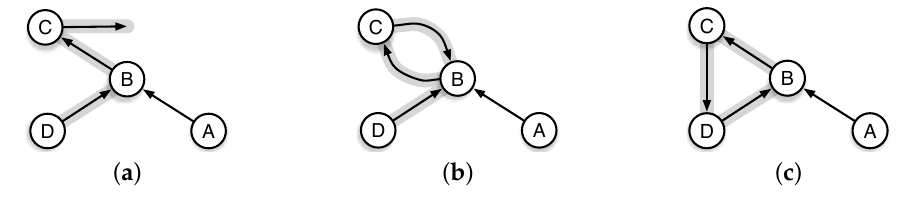
Figure 1. Illustration of the typical routing loops. ( a ) no loop; ( b ) 2-node loop; ( c ) 3-node